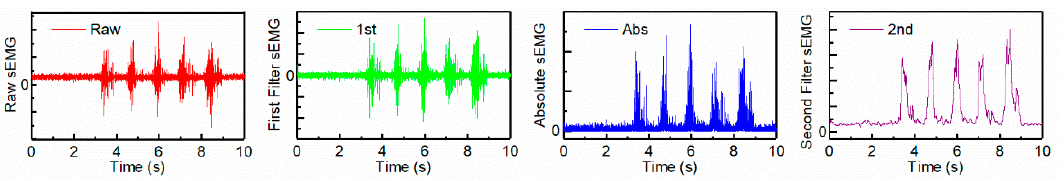
Figure 4. The signal processing of sEMG.